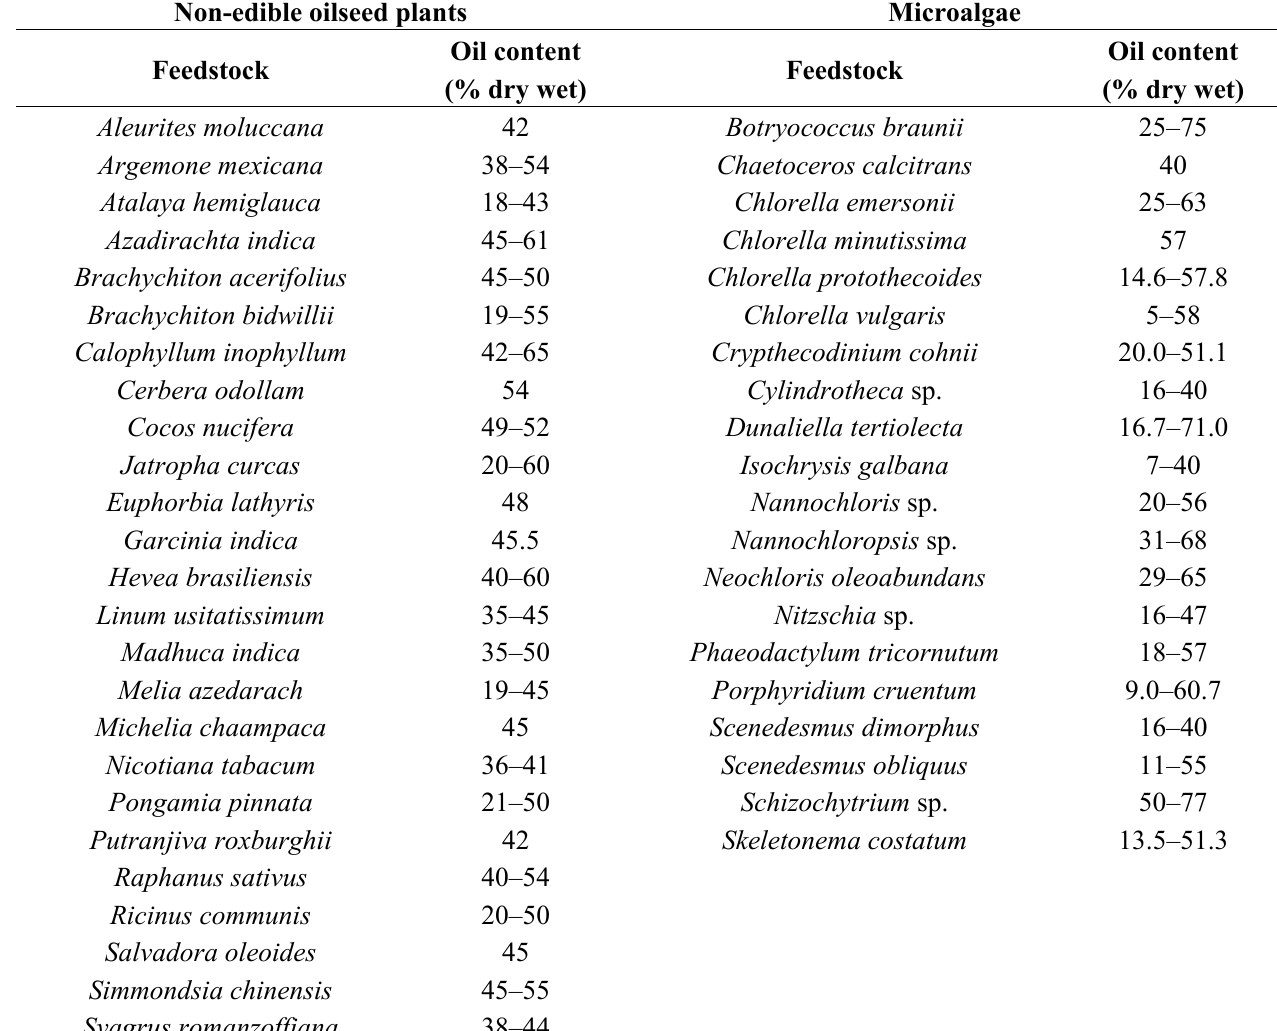
Table 2. Second-generation biodiesel feedstock containing at least 40% oil by